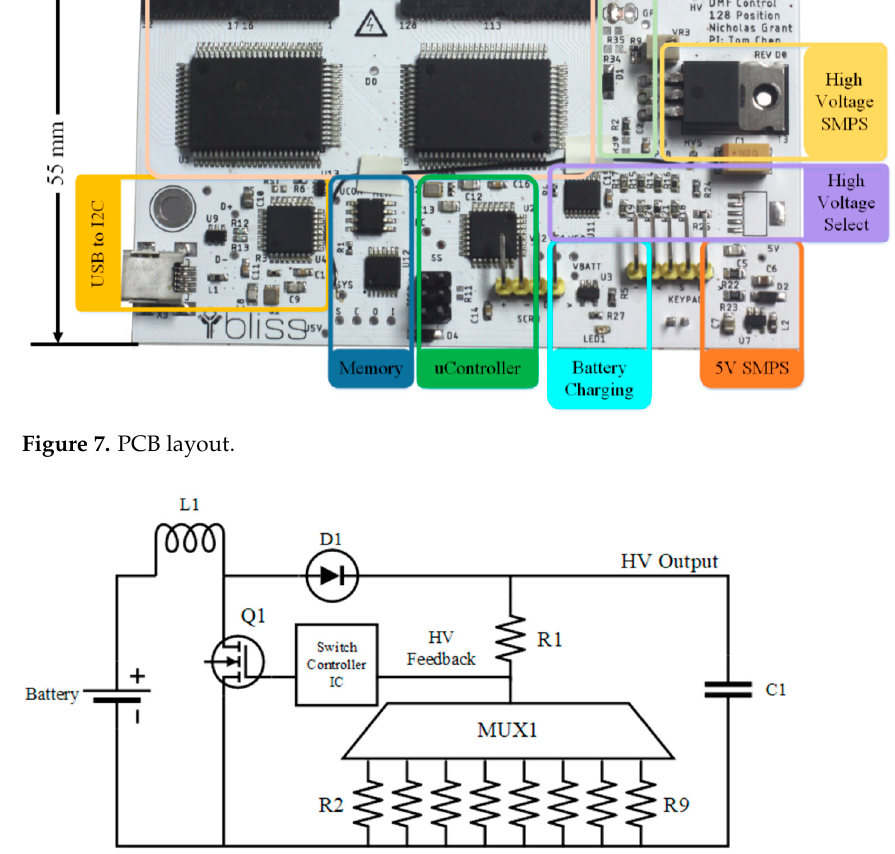
Figure 8. Adjustable high voltage SWPS.